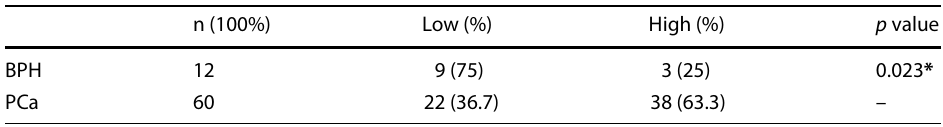
Table 1 Expression of CIP2A in BPH and PCa tissues